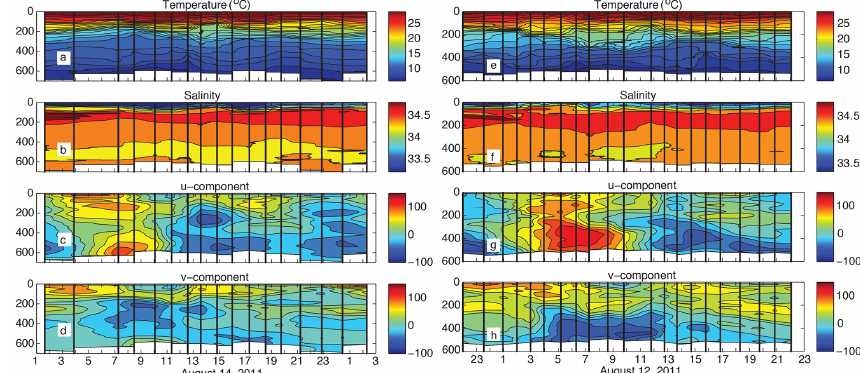
Figure 3. CTD and LADCP data for stations AW (left panels) and AC (right panels) at 21 ◦ 34.1 (cid:48) N, 120 ◦ 49.7 (cid:48) E and 21 ◦ 34.1 (cid:48) N, 120 ◦ 54.1 (cid:48) E, respectively. The vertical solid lines represent the times of the individual CTD/LADCP casts.